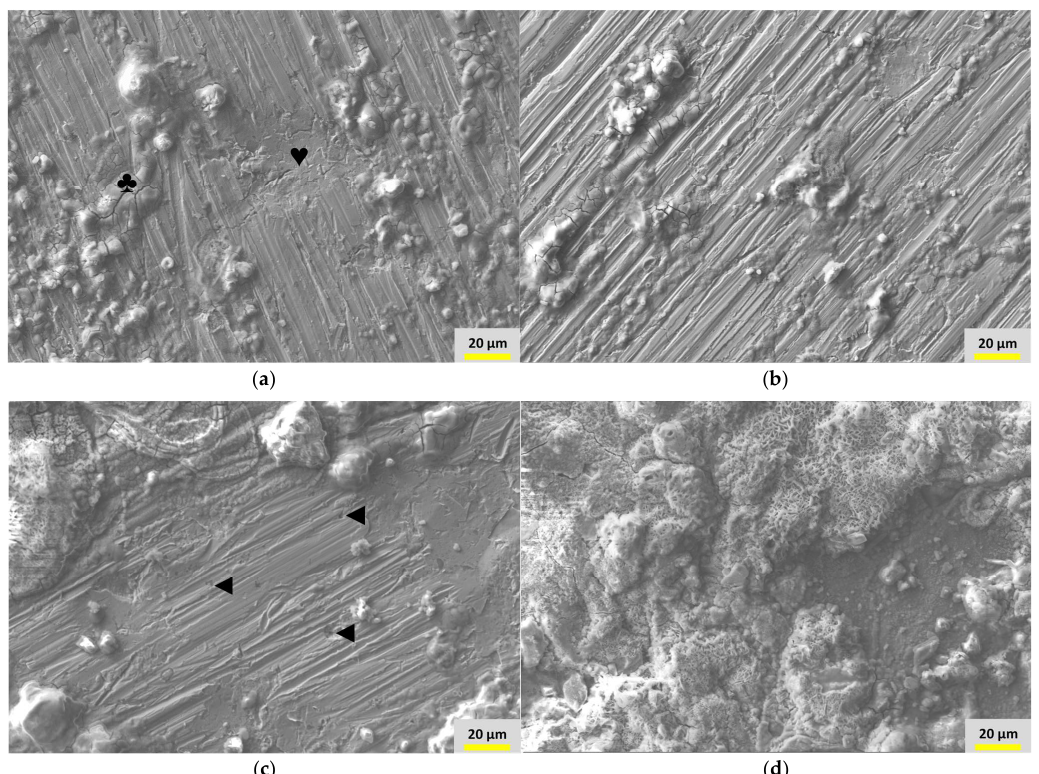
Figure 13. SEM photographs of carbon steel samples in position P2 at 32 days ( a ), 74 days ( b ), 120 days ( c ), and 241 days ( d ) of exposure.